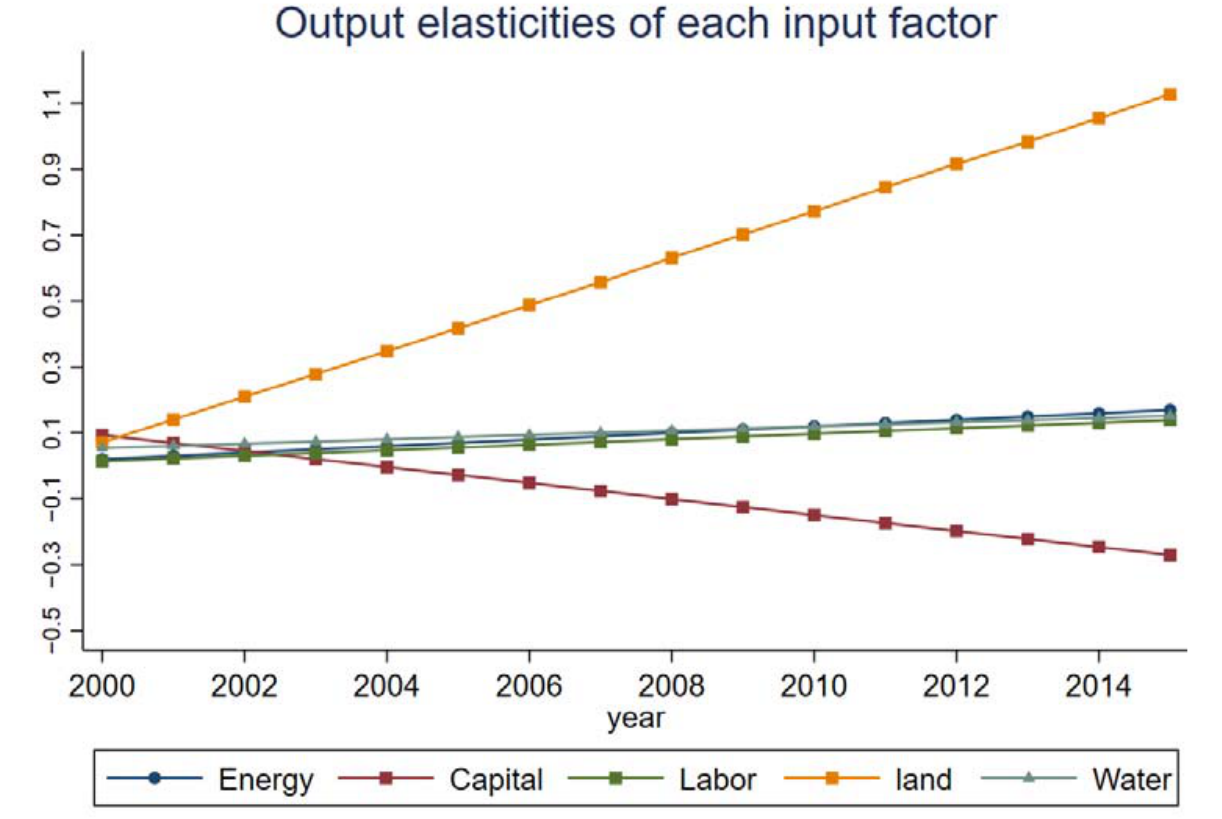
Figure 4. Output elasticities of each input factor. Table 5. Output elasticities of each input factor.